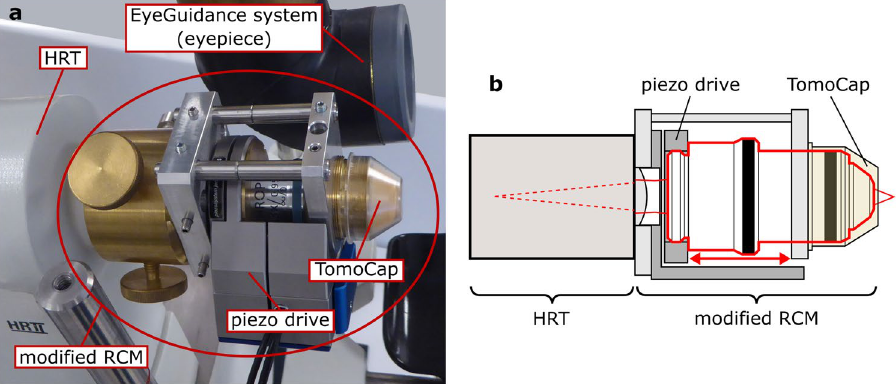
Figure 2. The modified Rostock Cornea Module (RCM). ( a ) Photograph of the modified RCM attached to the HRT II and next to the eyepiece of the EyeGuidance system. ( b ) Schematic drawing of the modified RCM; the piezo drive translates the objective (highlighted by red border) to effect focus changes; the contact TomoCap remains fixed in the process.